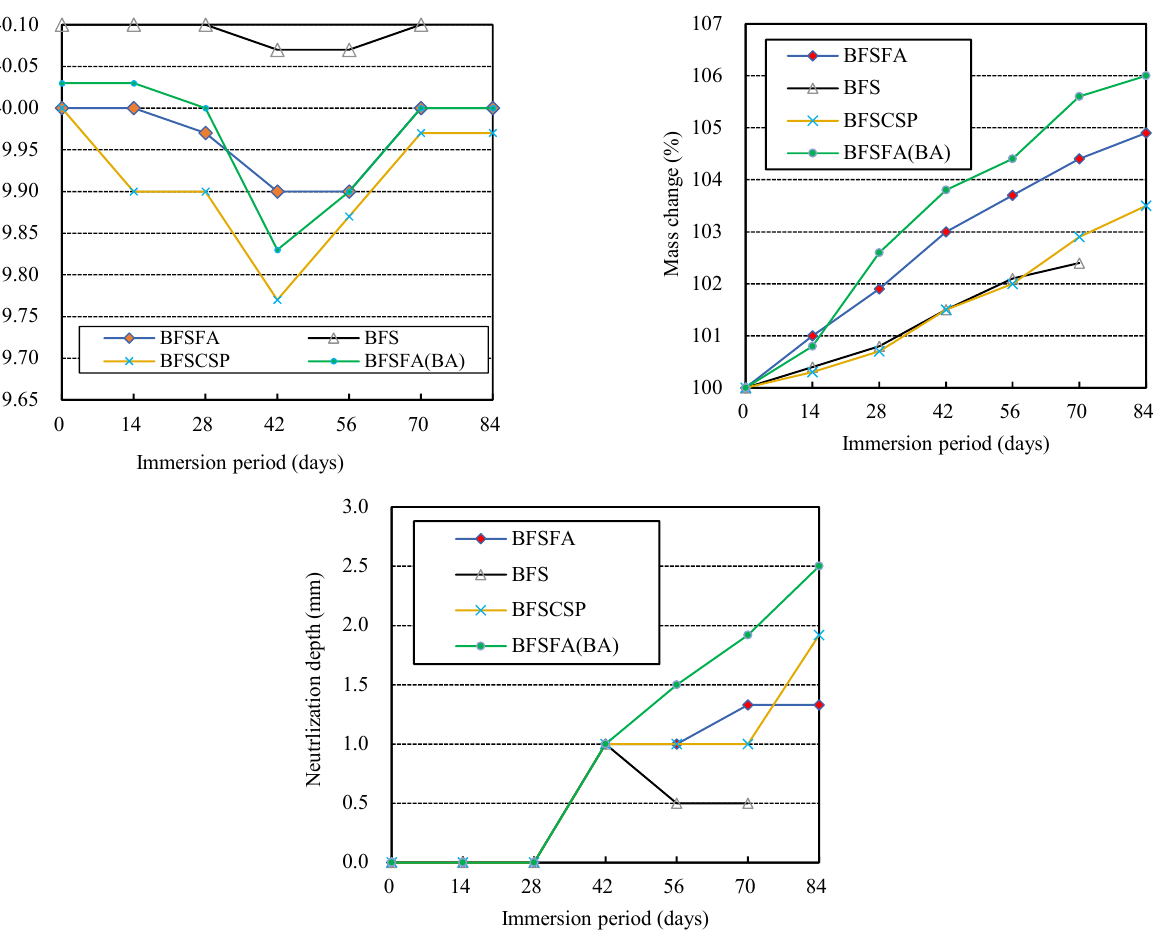
Figure 9. Effects of precursor used on the acid resistance of geopolymer. The CSP and the BA are inactive, and the BA has a porous structure, so the polymer- ization reaction products in the BFSCSP specimen should be less than that of the BFSFA specimen, and the permeability of the BFSFA(BA) should be greater than that of the BFSFA. Permeable voids and high water absorption of AAM can contribute to the H 2 SO 4 attack of AAFS [19]. Thus, the neutralization depths of the two specimens were greater than that of the BFSFA. The BFSFA(BA) chemical degradation was the fastest in the sulfuric acid solution among the four specimens. Hence, replacing FA in AAFS with CSP or adding BA to AAFS will increase Ca-rich AAMs’ physical and chemical degradation. Li et